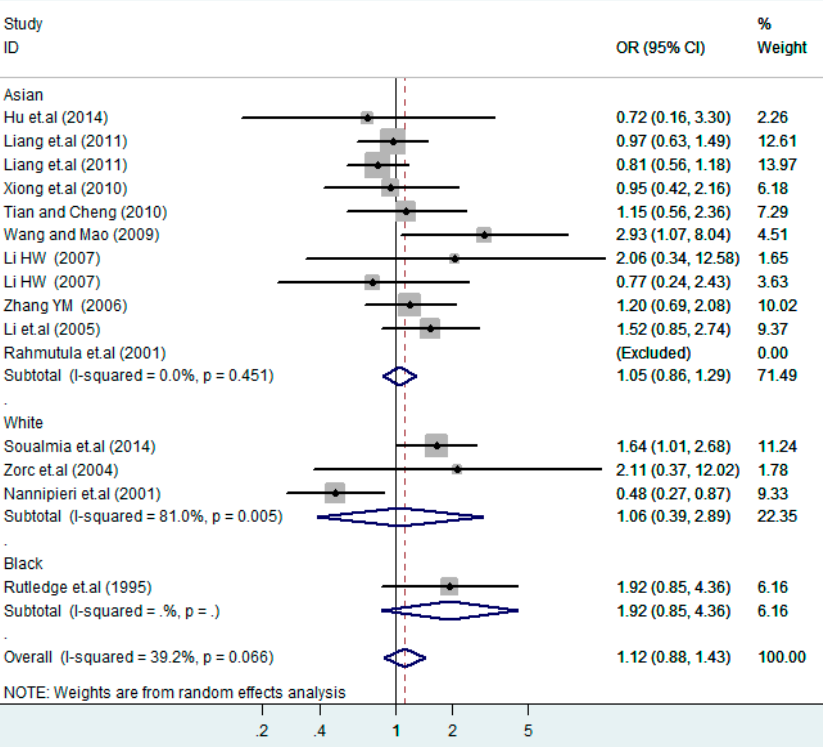
Figure 13. Ethnic subgroup analysis of T2238C recessive model CC vs. (TT + TC).